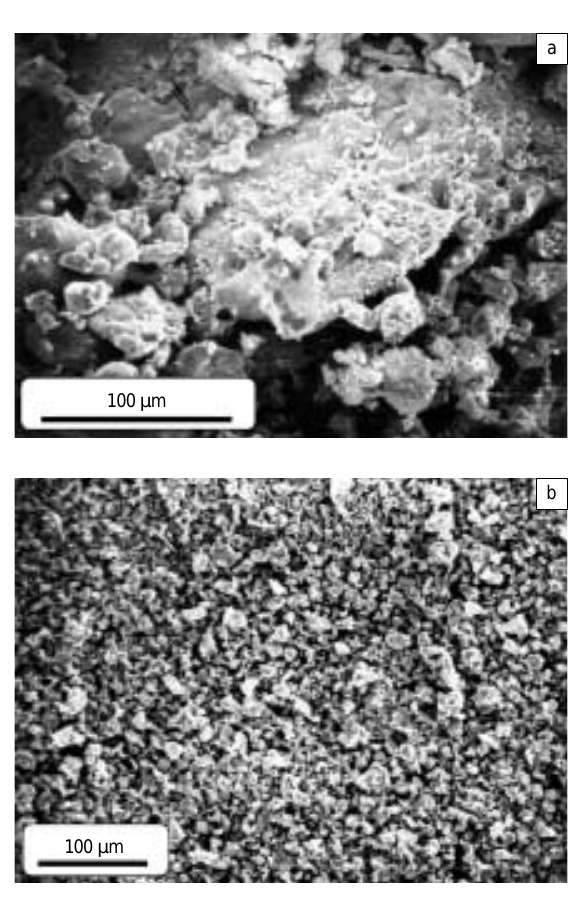
Fig. 4 Microphotograph of the SHS product in the system of Ni 16 wt.% Si (a), the product of mechanical alloying in this system for 10 min.